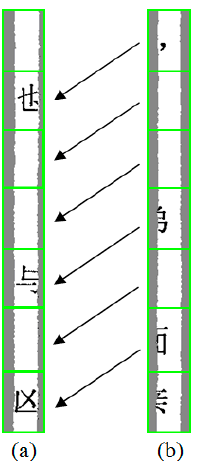
Figure 5. Example of the interrelationships among the leftmost piece and the rightmost piece on the same page: ( a ) leftmost piece of the document; ( b ) rightmost piece of the document. The green frame represents the space range of the block in each text line.